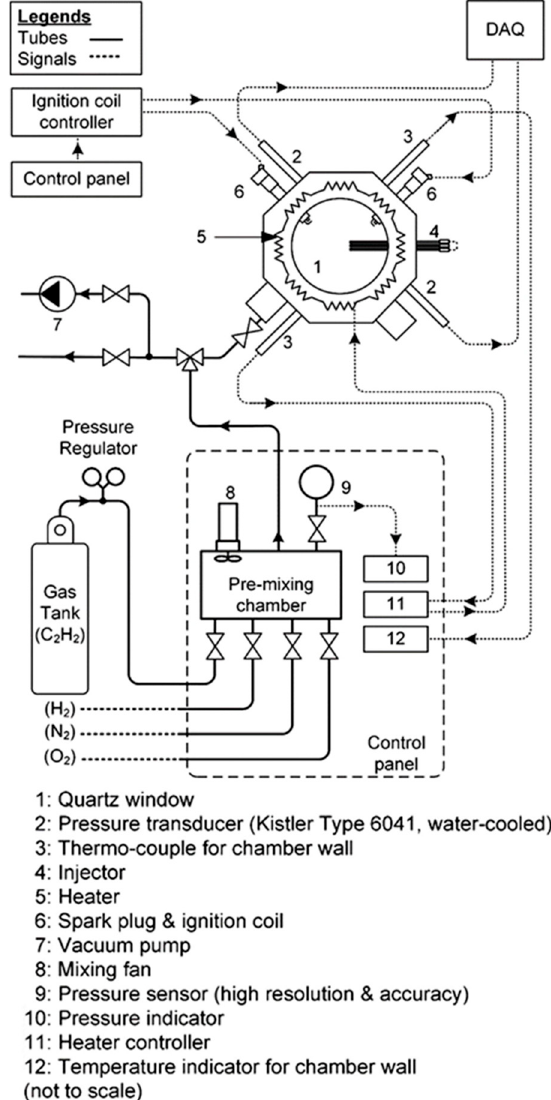
Figure 3. Constant volume combustion chamber (CVCC); DAQ: data acquisition system. Table 4. CVCC specifications.